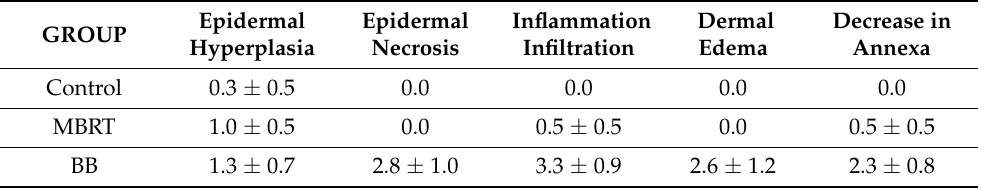
Table 2. Total summarized scores from histology evaluation in each treatment